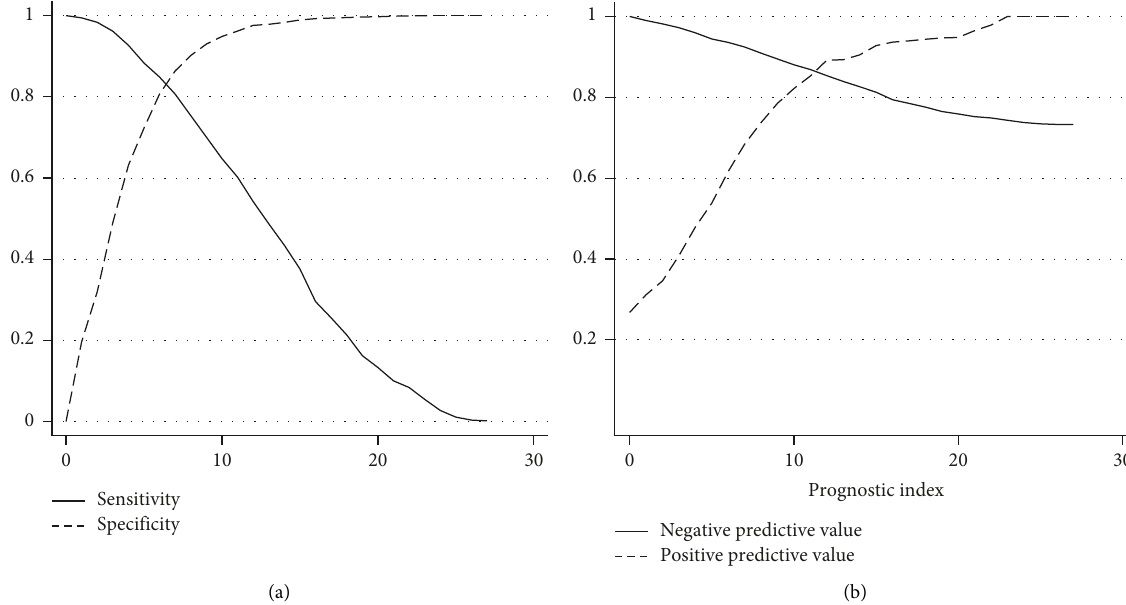
Figure 3: Sensitivity and specificity (a) and negative and positive predictive value (b) in the validation cohort. Y -axis represents proportions; X -axis represents the prognostic index.